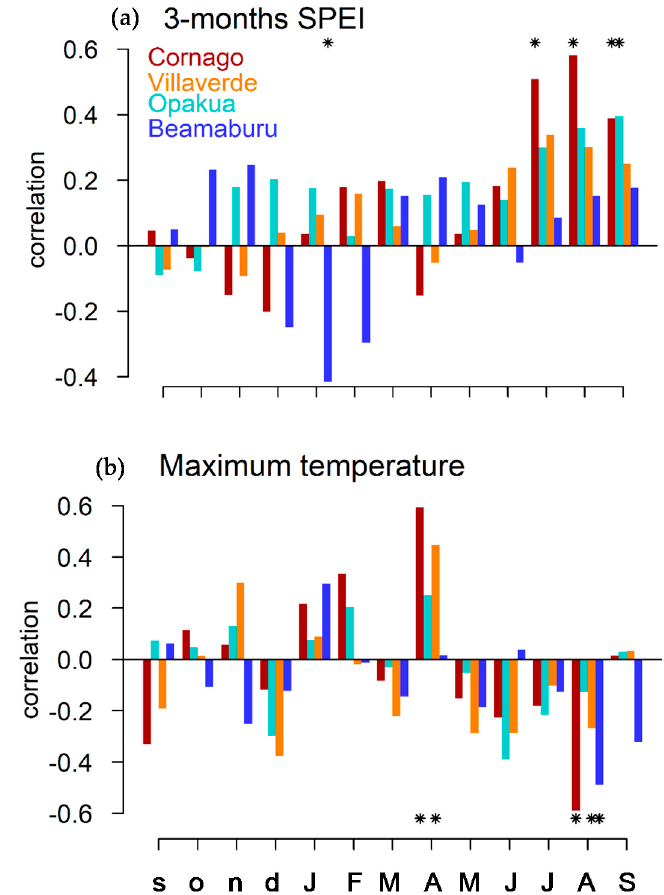
Figure 3. Relationships (Pearson correlations) between Douglas fir growth and climate. The rela- tionship between ring-width indices of Douglas fir 2014 with 3-month-long SPEI ( a ) and the mean maximum temperature ( b ) is represented with different colors for each site. Asterisks (*) indicate significant ( p < 0.05) correlations for each site (colors) in that month (lowercase letters for the previous year and uppercase letter for the current year).